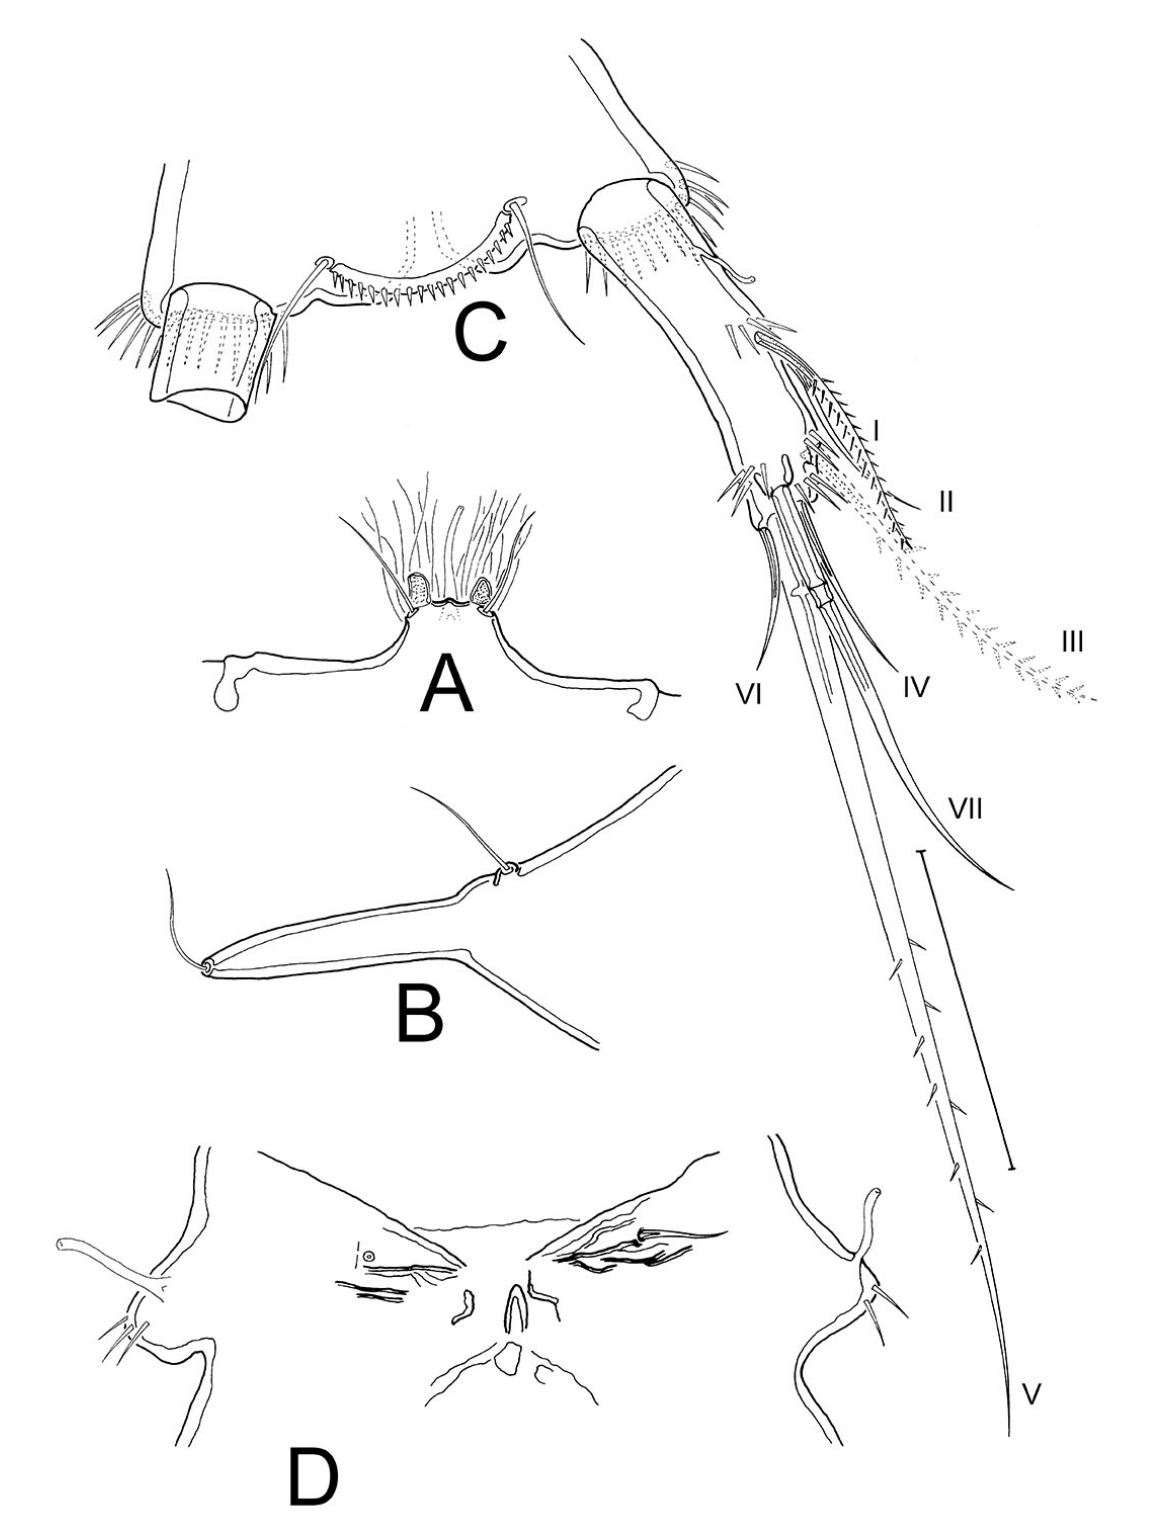
Fig. 9. Paratouphapleura aaroni gen. et sp. nov. A–C . Female holotype (SMF 37270/1). A . Rostrum, dorsal view. B . Left cephalothoracic posterior lateroventral process (CLVPp), dorsal view. C . Telson and right FR, dorsal view. D . Female paratype 3 (SMF 37273), genital field with P6. Scale bar: 50